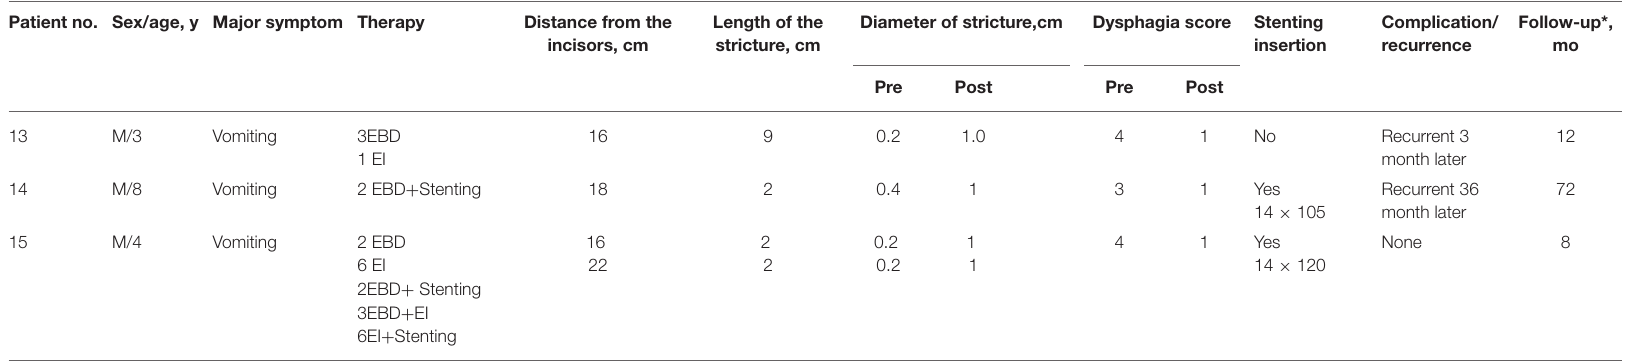
TABLE 3 | Treatment for congenital esophageal